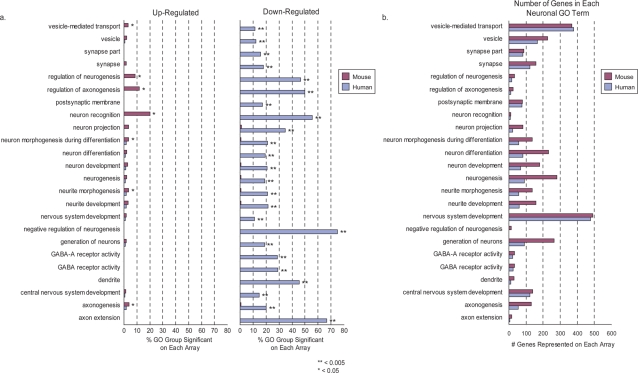
Neuronal gene ontology groups distinguish the expression profiles of the aging human and mouse cortex.a. Neuronal gene ontology (GO) groups that are significantly enriched (p-value≤0.005; binomial approximated p-value for a hypergeometric distribution) for age-related expression changes (SAM comparison, FDR≤0.01) were identified. The X-axis represents the percentage of genes in a GO group with age-related up- or down-regulation. Multiple neuronal GO groups are enriched in the human aging profile; while only a few neuronal GO terms appear at less significant thresholds in the mouse aging profile. Age-upregulated and age-downregulated genes are shown separately. b. Number of genes in each GO group that are represented on the mouse and human microarray platforms.